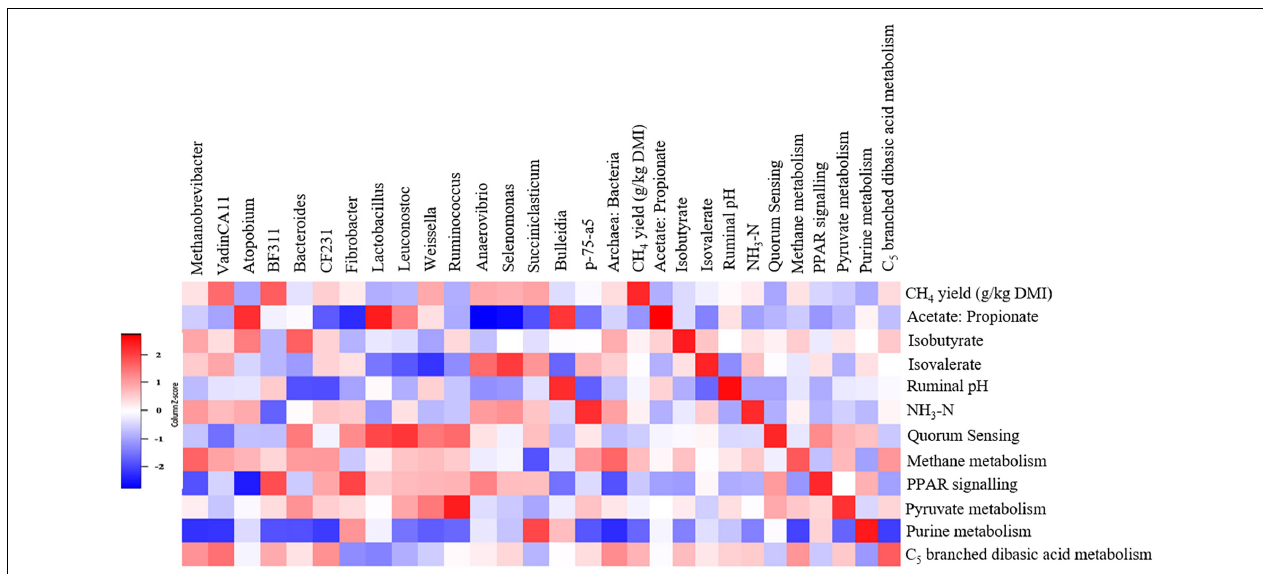
FIGURE 9 | Associations among methane yield, fermentation parameters, rumen microbes, and metabolic pathways in steers. The genera and metabolic pathways were included in the matrix if they were differentially abundant ( P < 0.1) and had at least 0.01% relative abundance in at least one of the steers. Correlation strength is indicated by the intensity of the colour. The scale colours denote whether the correlation is positive (closer to 1, red squares) or negative (closer to − 1, blue